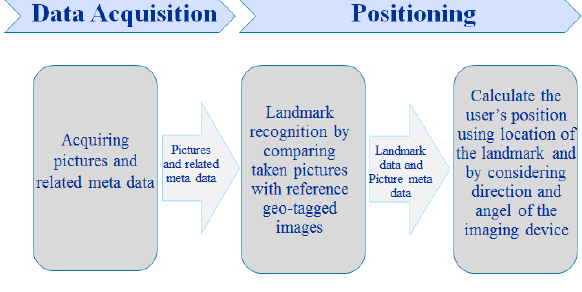
Figure 1 . Traditional approach of visual